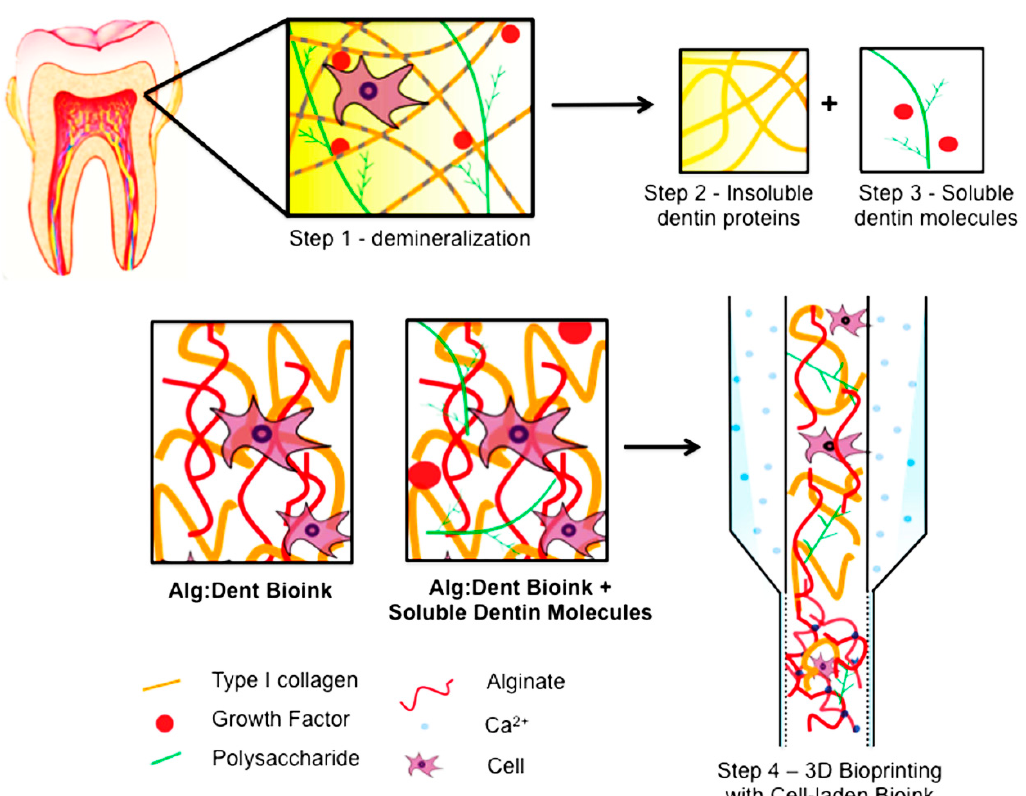
Figure 6. Schematic description of the dentin bioink for 3D-bioprinting. The bioink was made of insoluble dentin proteins, soluble dentin molecules and alginate hydrogel. (From Athirasala [70] Biofabrication , with permission.)